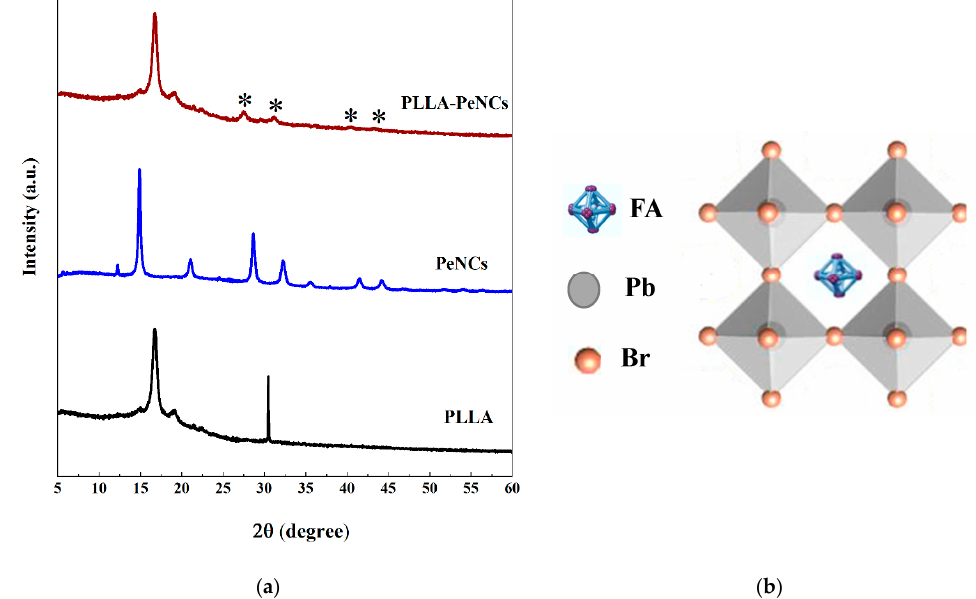
Figure 4. ( a ) X-ray diffraction pattern of pure FAPbBr 3 NCs, PLLA, and PeNCs–PLLA nanofibres; * indicates the peaks belonging to FAPbBr 3 . ( b ) The cubic crystal structure of FAPbBr 3 NCs at room temperature.